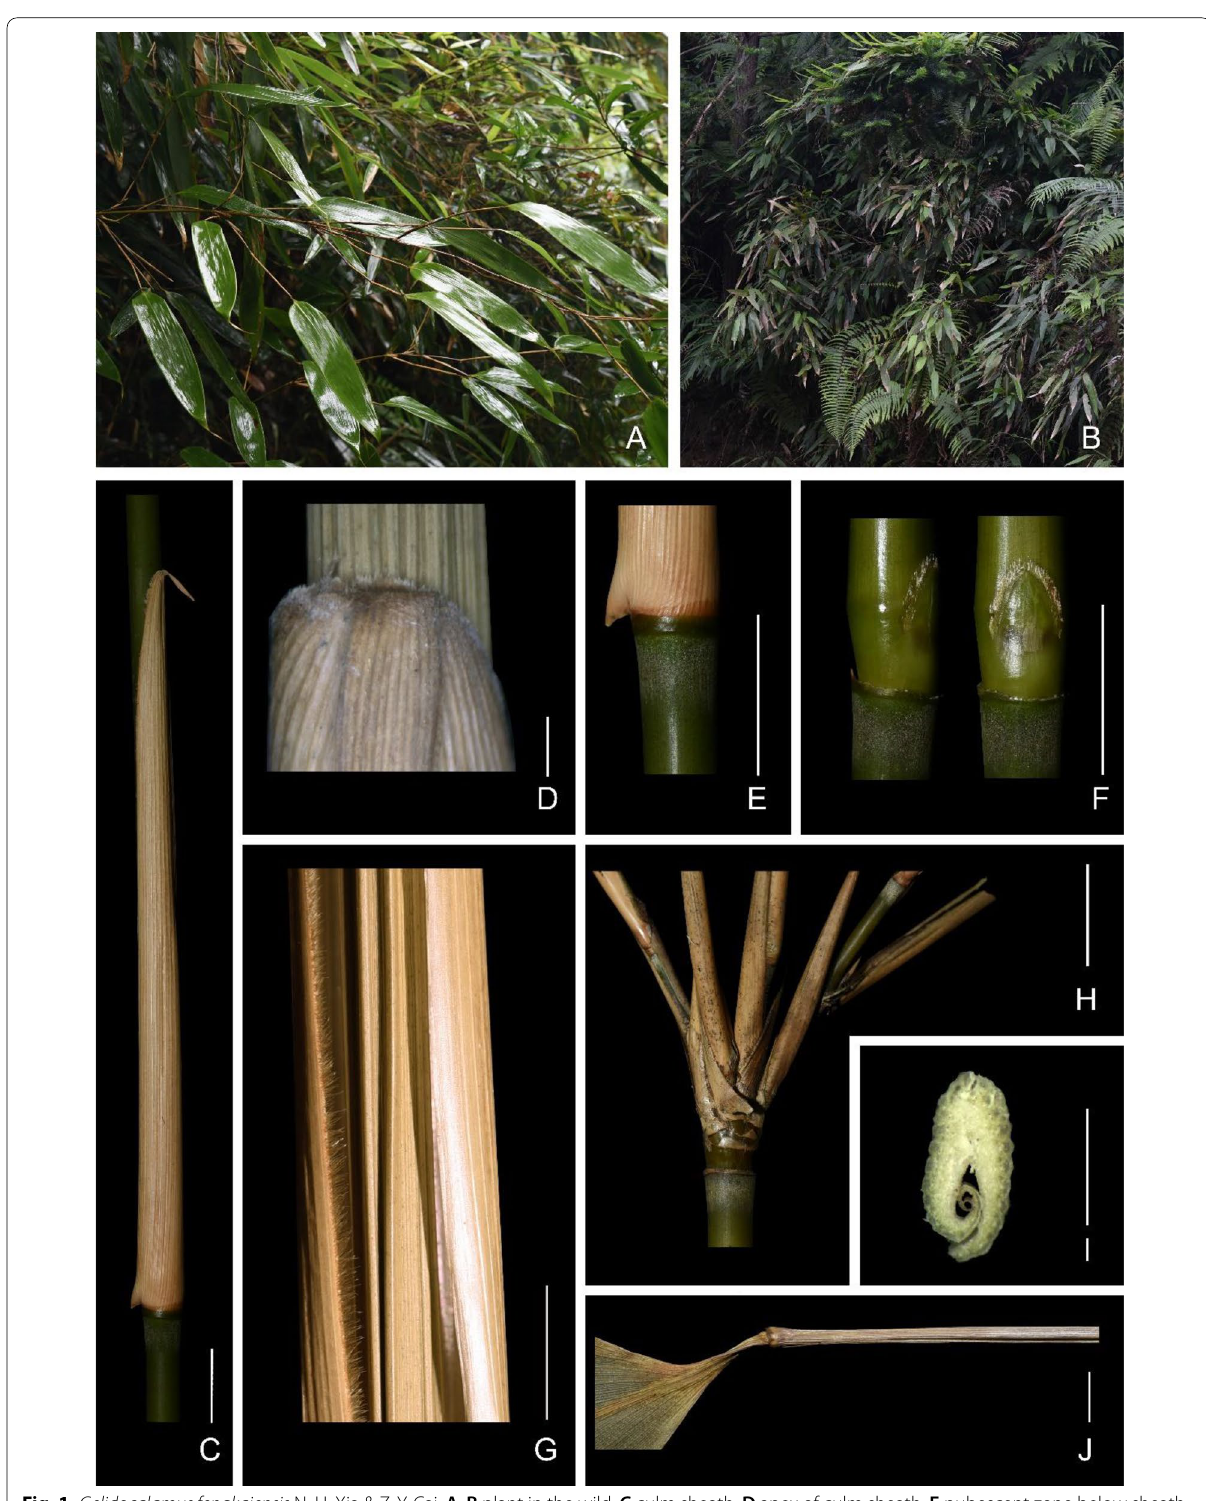
Fig. 1 Gelidocalamus fengkaiensis N. H. Xia & Z. Y. Cai. A , B plant in the wild; C culm sheath; D apex of culm sheath; E pubescent zone below sheath scar, F primary bud; G culm sheath margin; H branches at mid‑culm; I cross section of terminal leaf sheath; J terminal leaf sheath. Scale bars: D and I 1 mm; C , J and E – H 1